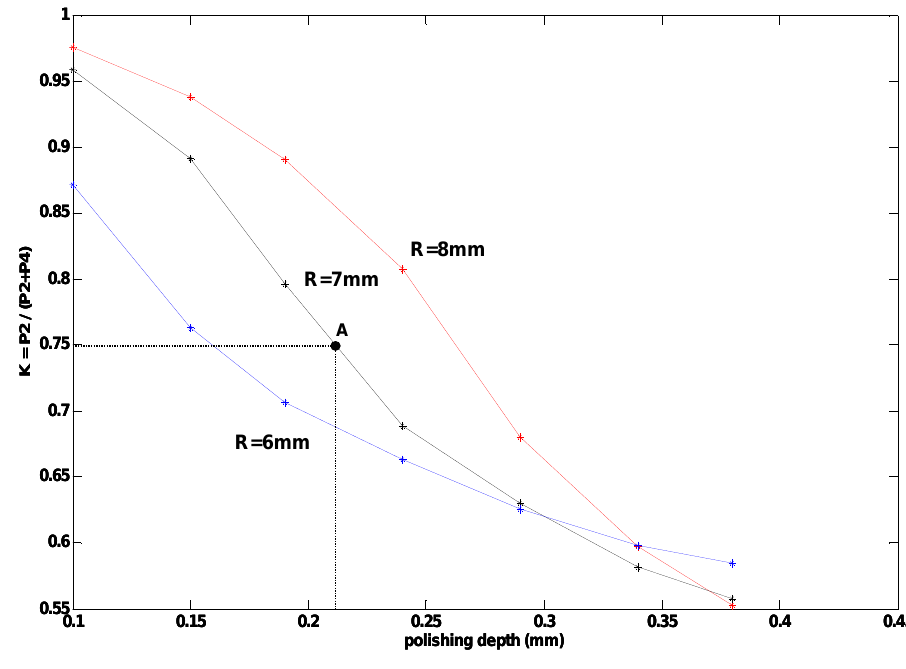
Figure 2. K versus polishing depth simulation for different bending radii (6, 7 and 8 mm) considering water as the external